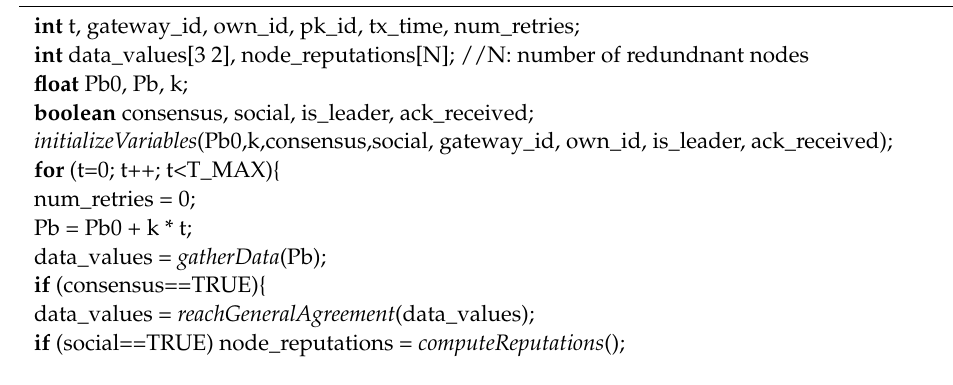
Algorithm A1: Sensor Node Application